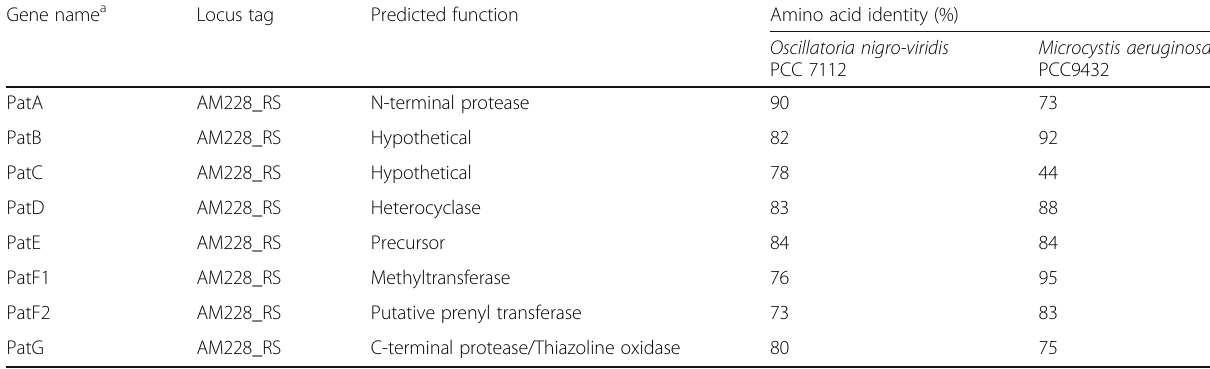
Table 5 Gene cluster encoding cyanobactins detected in strain SR001